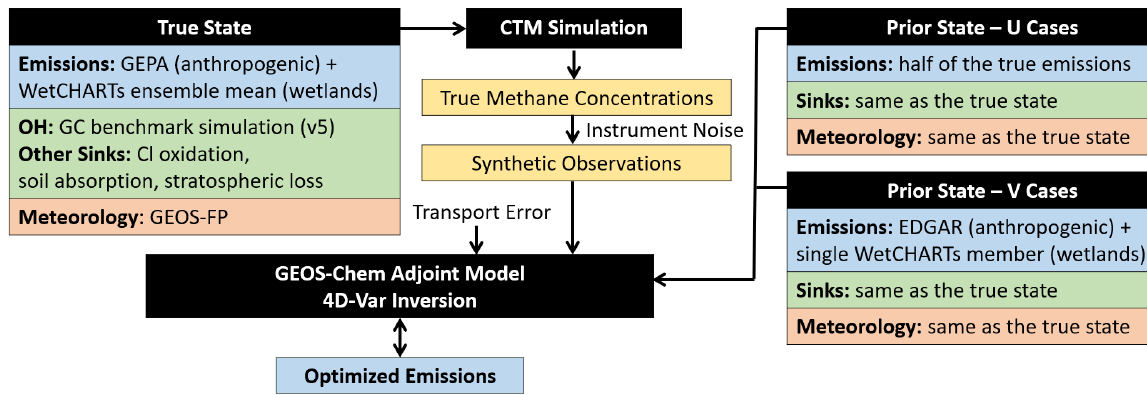
Figure 1. Schematic illustrating the OSSE framework used here.